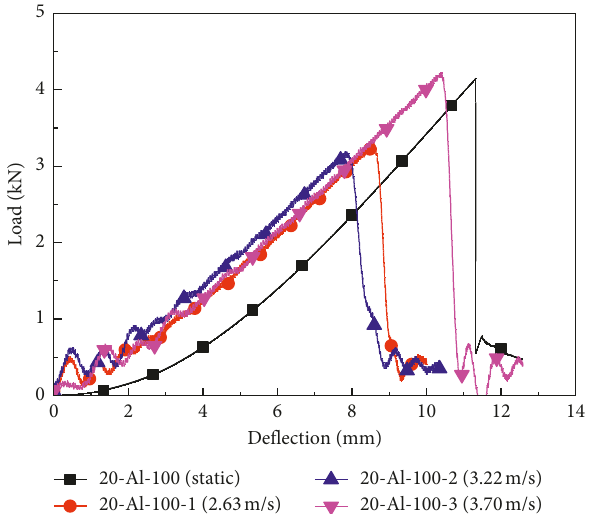
Figure 2: Load-deflection curves from static and drop-weight impact tests on the 2A12-T4 aluminum alloy sheet with a diameter of 100mm loaded by the hemispherical projectile with a diameter of